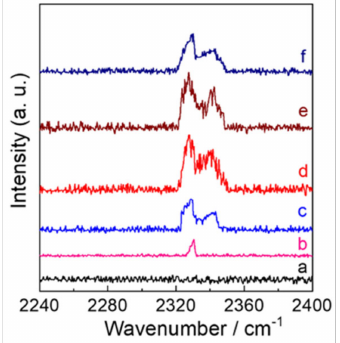
Figure 5. Raman spectra in the wavenumber region of 2240–2400 cm − 1 for (a) WO 3 − 0, (b) WO 3 − 0.62, (c) WO 3 − 1.2, (d) WO 3 − 2.5, (e) WO 3 − 5, and (f) WO 3 − 7.5,